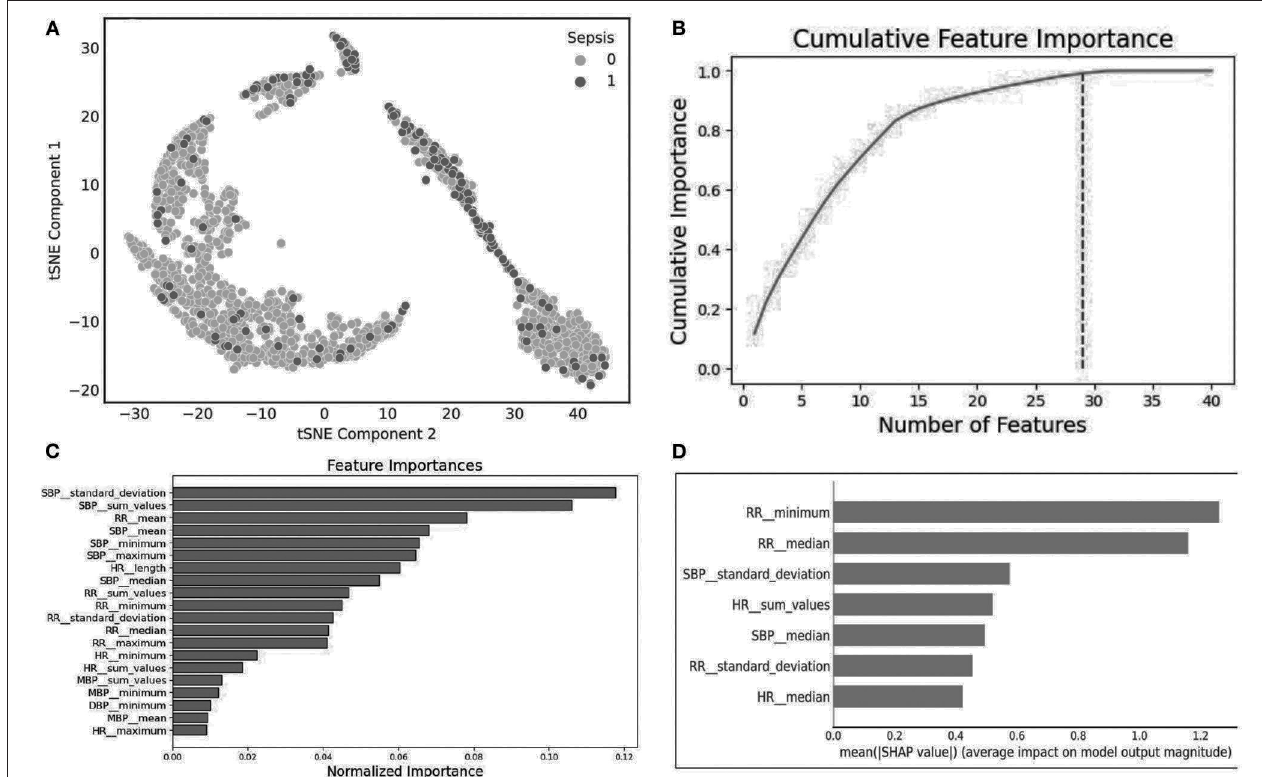
FIGURE 1 | (A) t-Distributed stochastic neighbor embedding (tSNE) plot characterizing sepsis (dark purple) and non-sepsis clusters (pink); (B) cumulative feature importance identifies 29 features that explain 99% of the data; (C) feature importance generated using light gradient boosted machines; (D) explainable importance with SHapley Additive exPlanations (SHAP) after feature